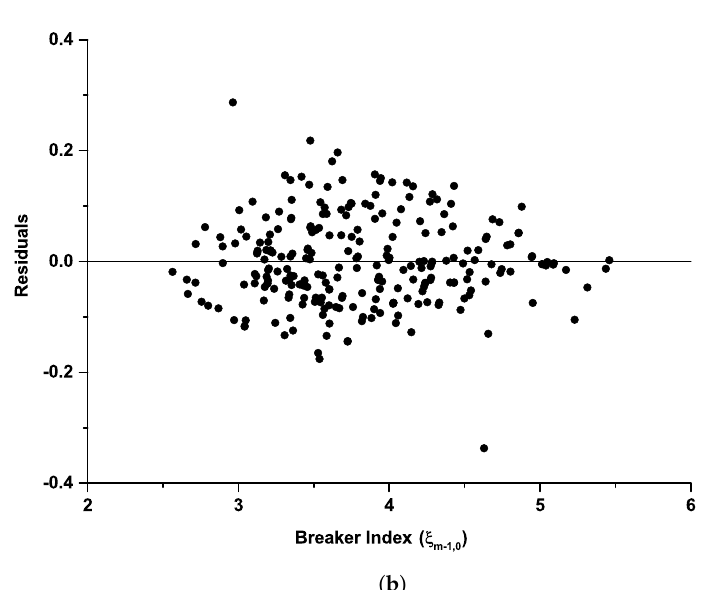
Figure 11. Comparison between the measured K r and the predicted K r of the wave reflection coefficient ( a ) cot α = 1.5; and ( b ) cot α =